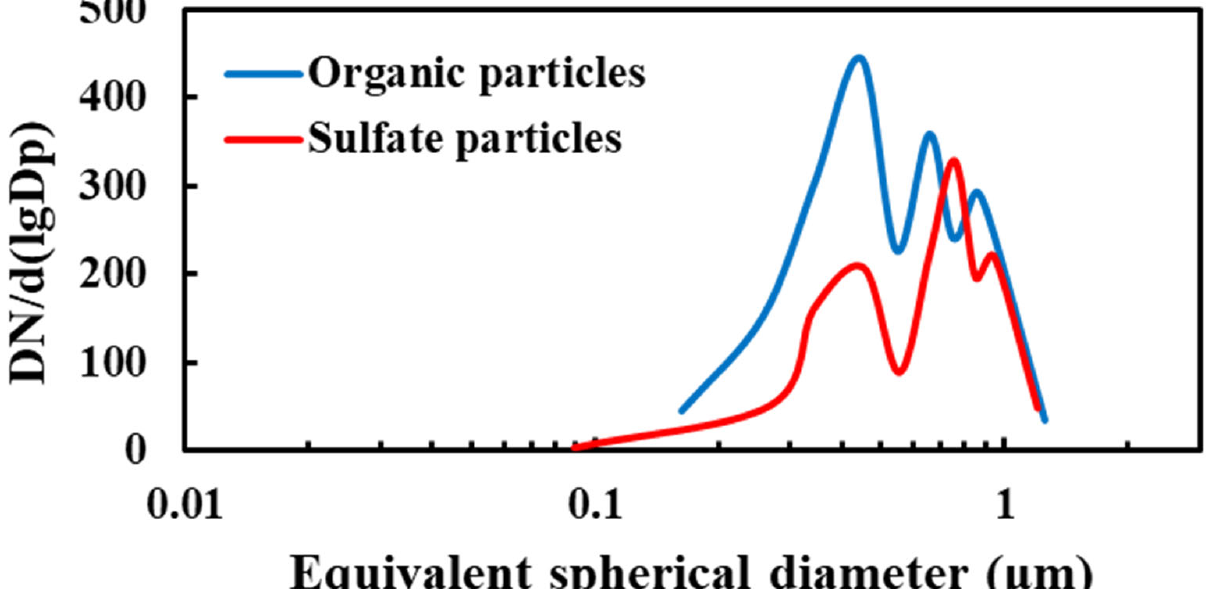
Figure 5. Size distributions of organic particles and sulfate particles in the winter haze of Xi’an dur ‐ ing the sampling period. N is the total number of particles in due size, and d(lgDp) is the derivative of the logarithm of the particle diameter Dp (Dp is the equivalent spherical diameter of analyzed individual particles) in the caption.